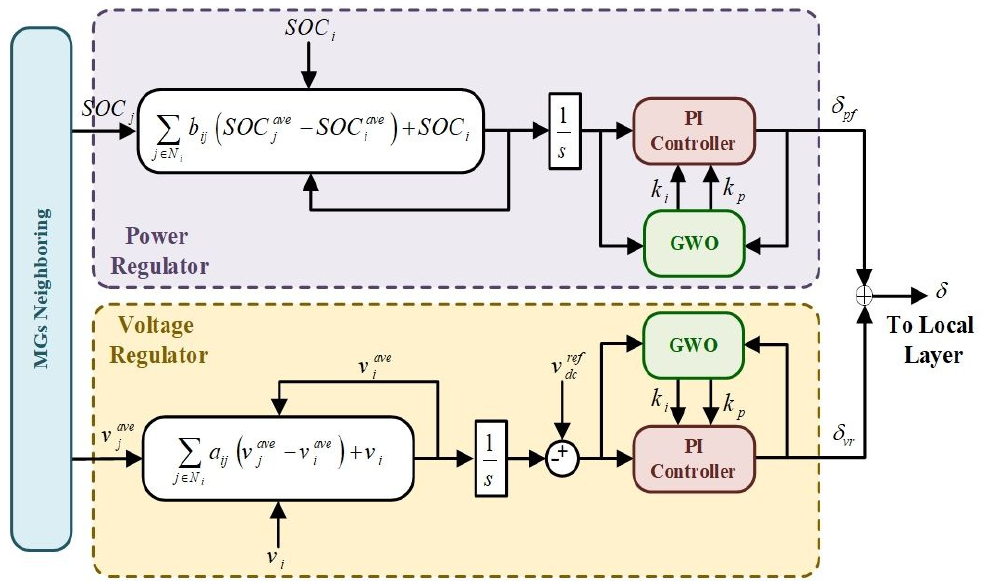
Figure 5. Proposed Control Method.